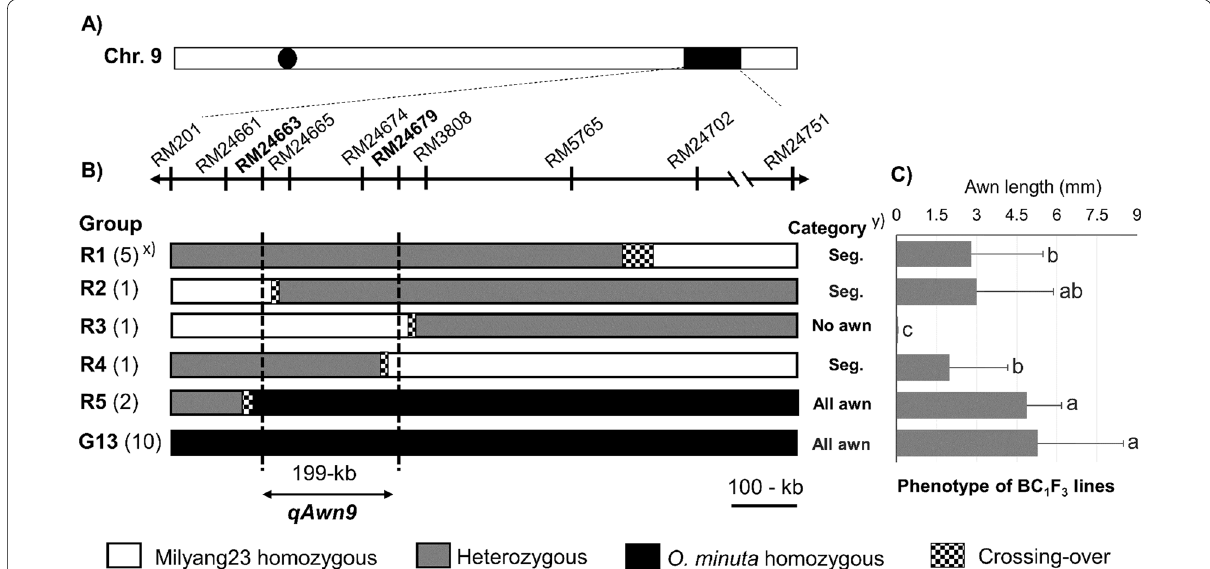
Fig. 5 Fine mapping of qAwn9 . A Chromosomal location of qAwn9 . B Genotypes of five groups of BC 1 F 2 recombinant plants and homozygous lines G13 as the control. Black, white, and gray bars denote O. minuta, Milyang23, and heterozygous segments, respectively. C Phenotypes of BC 1 F 3 lines. Means labeled with different letters are significantly different among lines (Tukey’s test at p < 0.05). x) Numbers in parenthesis indicate the number of plants. Y) “Seg.” means segregation for awning that was determined by a t ‑test between two homozygous plants. Progeny tests of recombinants delimited qAwn9 to an approximately 199‑kb region flanked by markers RM24663 and